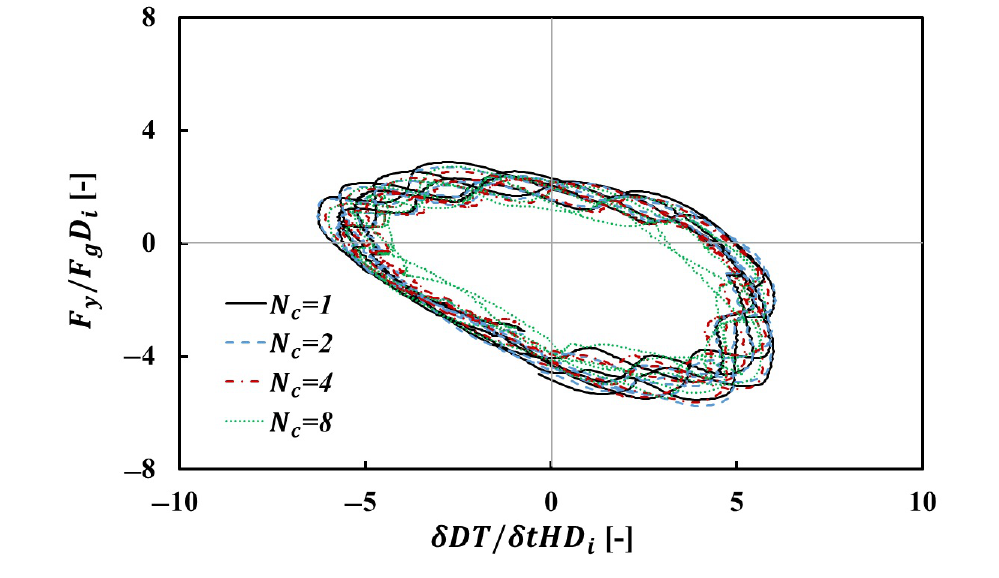
Figure 22. Normalised force–velocity diagram for the last five oscillation cycles with D i = 0.5.